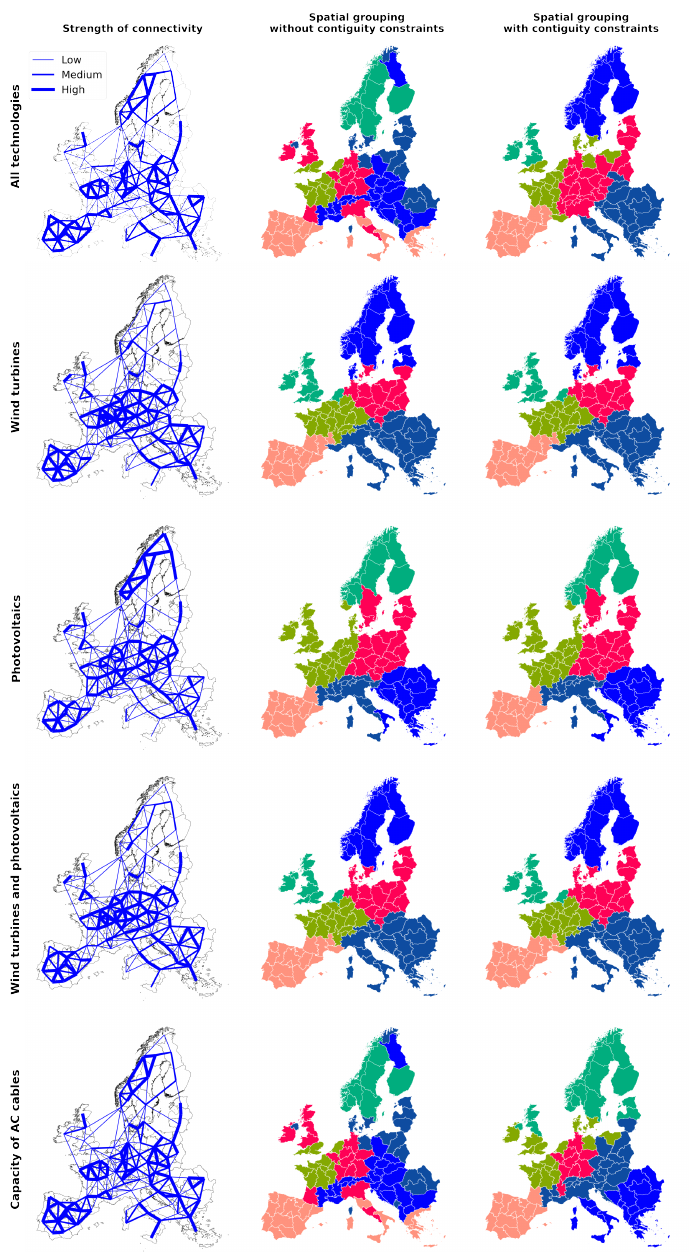
Figure A1. Region groups obtained when the 96 regions are spatially aggregated, to obtain 6 regions based on different sets of